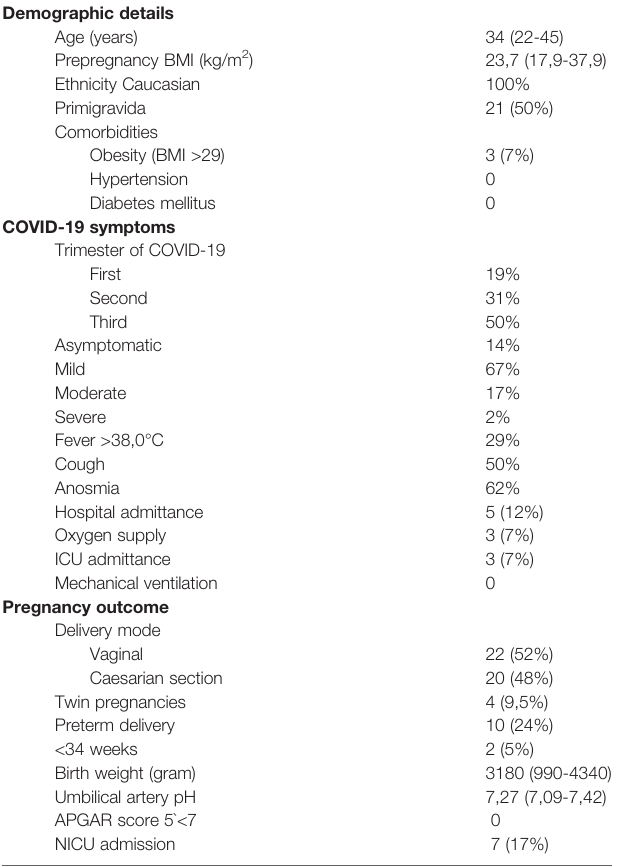
TABLE 1 | Demographic details, gestational time point and course of SARS- CoV-2 infection and pregnancy outcome in study participants. Demographic details Age